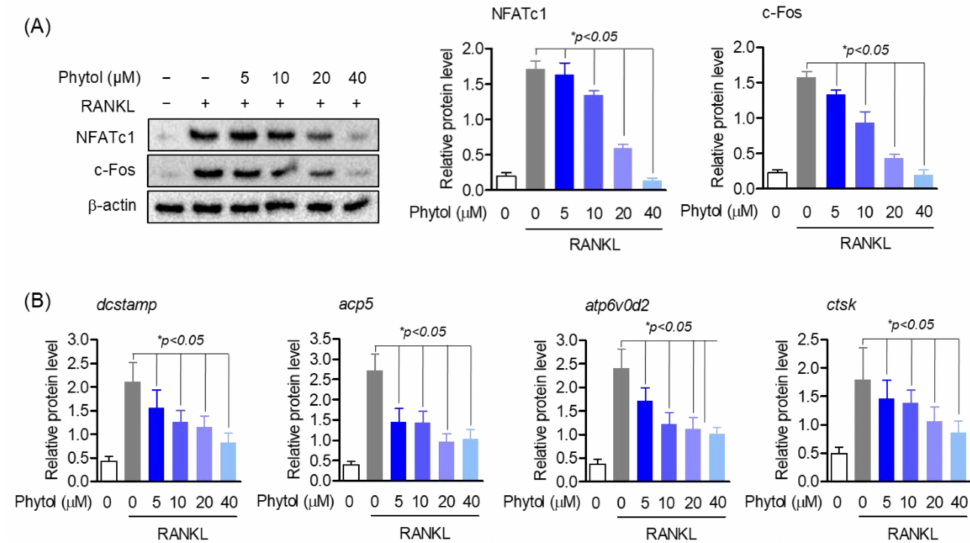
Figure 5. Phytol decreases the expression of osteoclast marker genes and transcript factors. The cells were pretreated with 5 − 40 µ M phytol before stimulating with 50 ng/mL receptor activator of nuclear factor kappa-B ligand (RANKL). ( A ) Western blotting was used to investigate the expression of NFATc1 and c − Fos protein level. ( B ) To detect the mRNA expression of dcstamp , acp5 , atp6v0d2 , and ctsk , RT-PCR was used. Data are presented as the mean of three independent experiments (Mean ± SD).